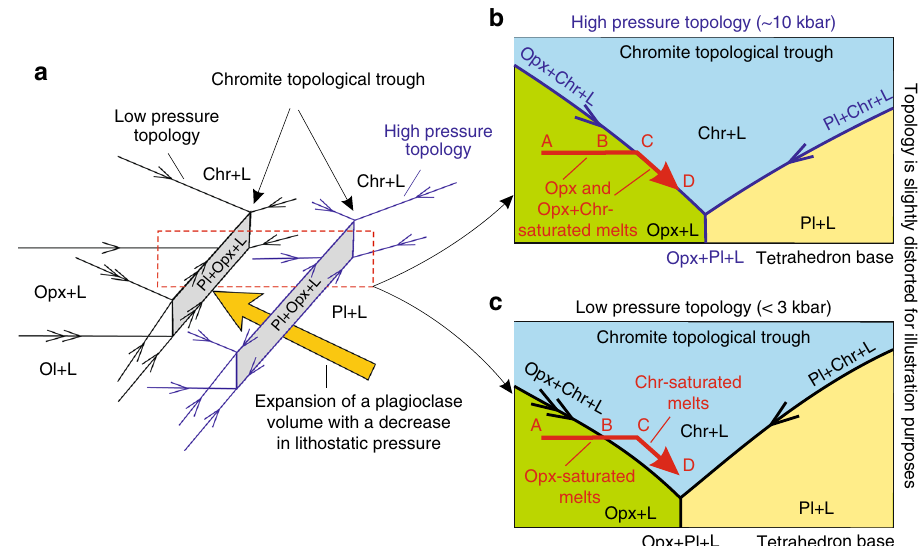
Fig. 3 A liquidus phase diagram illustrating the mechanism via which melts become saturated in chromite alone by pressure reduction. a Expansion of the plagioclase stability volume with decreasing pressure results in a shift of the chromite topological trough away from the plagioclase apex. b A high pressure section through the chromite topological trough and related stability volumes showing a range of basaltic melts saturated in orthopyroxene (from A to C) and orthopyroxene + chromite (from C to D). c The same section at lower pressures indicates that the most primitive melts (from A to B) will remain orthopyroxene-saturated over the entire pressure range. However, the less primitive orthopyroxene-saturated melts (from B to C) and all orthopyroxene + chromite-saturated melts (from C to D) will move into the chromite topological trough at lower pressure (e.g. ~0 – 3 kbar). Note that in this process the chromite stability fi eld does not expand but merely changes its position. The location of the section ( b , c ) is indicated by a rectangle in a , this rectangular section is not a temperature-composition binary